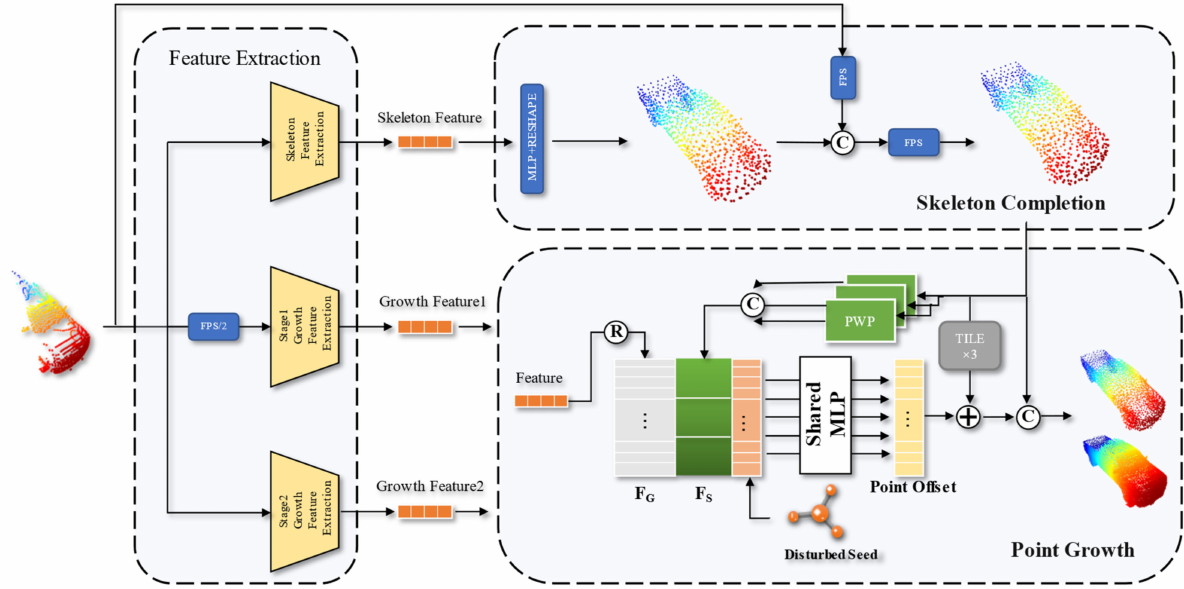
Figure 1. Overall framework structure of MAPGNet, composed of a composite encoder feature extraction module, a skeleton generation module and a point cloud growth module. FPS denotes the farthest point sampling. PWP is to extract the feature structure from the skeleton point cloud. ®denotes the copy operation. © denotes concatenation operation. ⊕ denotes add operation. Tile × 3 denotes copying the skeleton point cloud three times to form an N C × 3